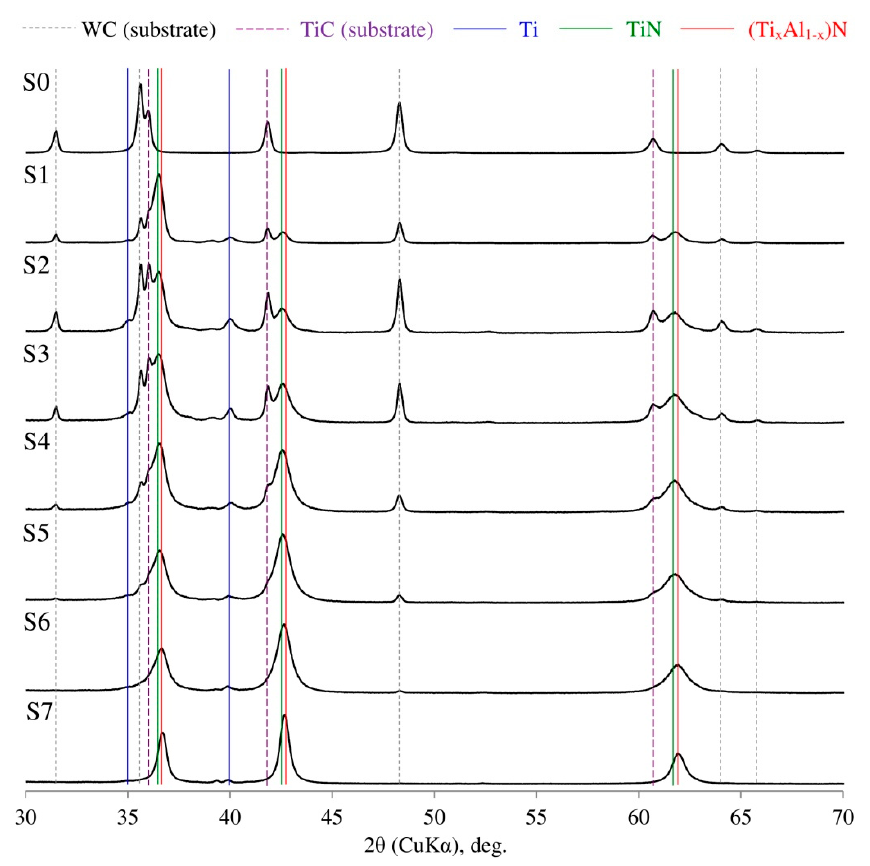
Figure 10. Analysis of the elemental compositions of the transition and wear-resistant layers of the coating. ( 1 ) Area adjacent to the substrate, ( 2 ) area of the transition layer on the border with the wear-resistant layer, ( 3 ) area of the wear-resistant layer on the border with the transition layer, and ( 4 ) area in the central part of the wear-resistant layer (at S4).